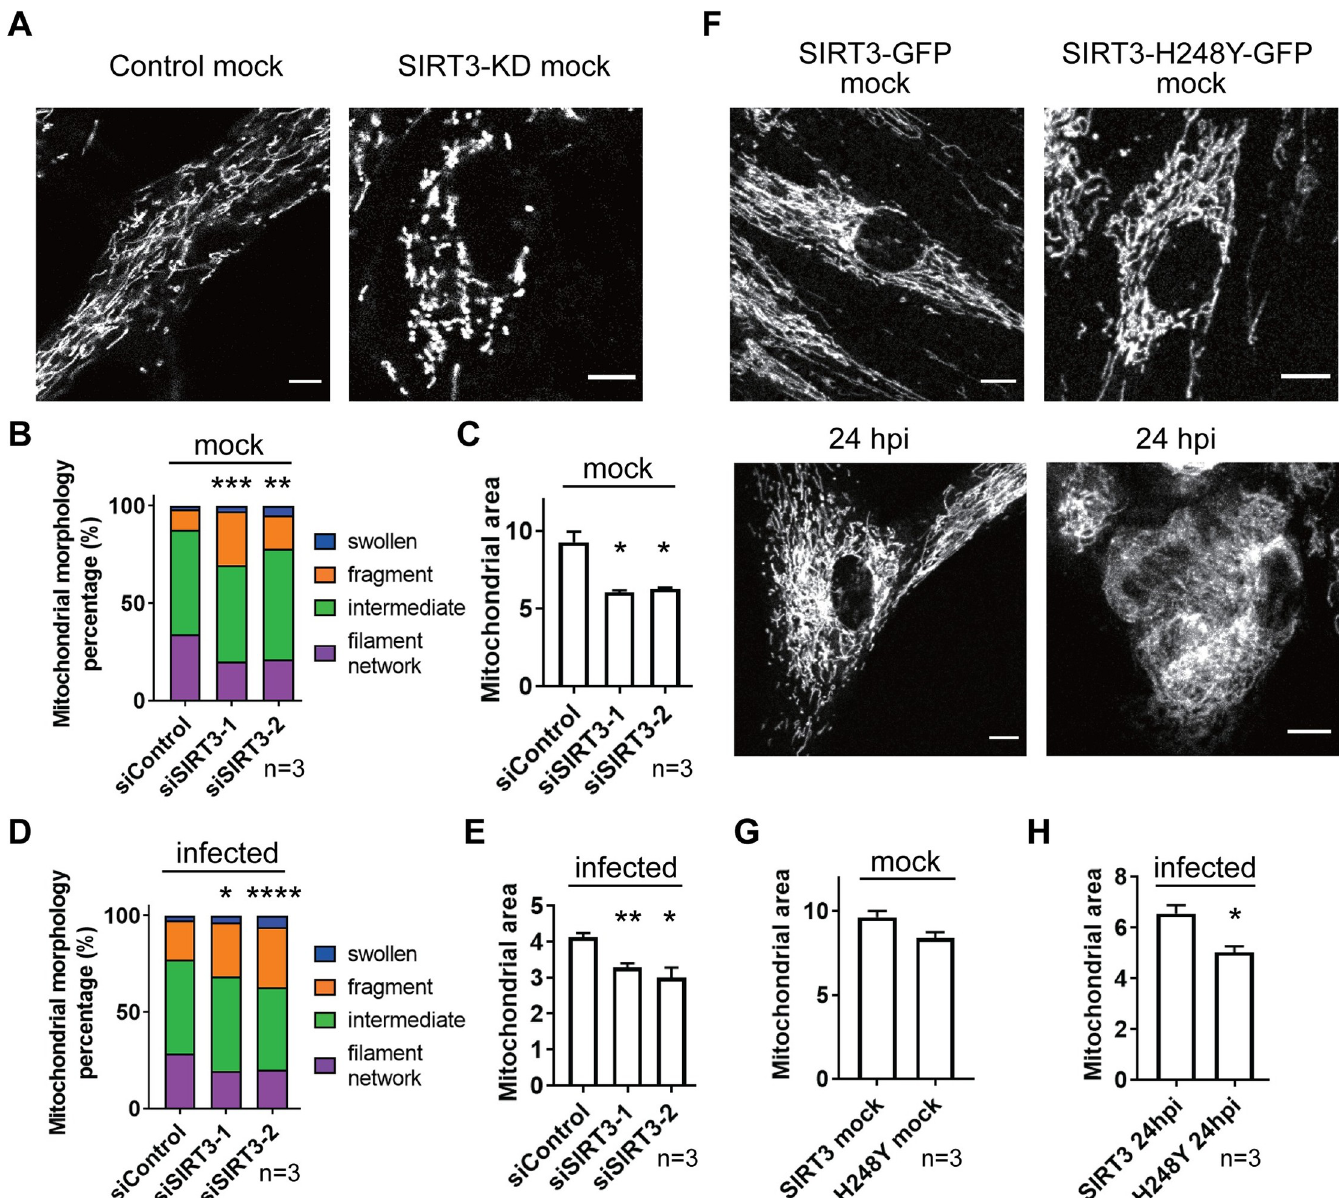
Fig 5. Control of SIRT3 levels or deacetylase activity is sufficient for modulating mitochondrial fusion. A. Representative microscopy images of mitochondria (visualized by MitoTracker Red CMXRos) in the context of SIRT3 siRNA-mediated knockdown (#1). Scale bar = 10 μ m. B-C. Mitochondrial morphology and mitochondrial area of uninfected cells with SIRT3 siRNA knockdown. MitoTracker Red CMXRos was used to stain the mitochondria. Student t-test was conducted to determine the statistical differences in fragment between control and knockdown groups. � p-value < 0.05, �� p-value < 0.01, ��� p-value < 0.005. Three biological replicates were used for each group (n > 60 cells per replicate). D-E. Mitochondrial morphology and mitochondrial area of infected cells (72 hpi) treated with SIRT3 siRNA constructs. Mitochondria were stained with MitoTracker Red CMXRos. Student t-test was conducted to determine the statistical differences in fragment between control and knockdown groups. � p-value < 0.05, �� p-value < 0.01, ���� p-value < 0.001. Three biological replicates were used for each group (n > 60 cells per replicate). F. Representative microscopy images of mitochondria (MitoTracker Red CMXRos) in uninfected (upper) and infected (24 hpi, lower) cells expressing of SIRT3 WT or deacetylation-deficient mutant. Scale bar = 10 μ m. G-H. Mitochondrial area quantification (based on MitoTracker Red CMXRos signal) of uninfected (G) and infected (H) cells expressing either SIRT3 mutant or WT. � p-value < 0.05. Three biological replicates were used for each group (n > 60 cells per replicate).